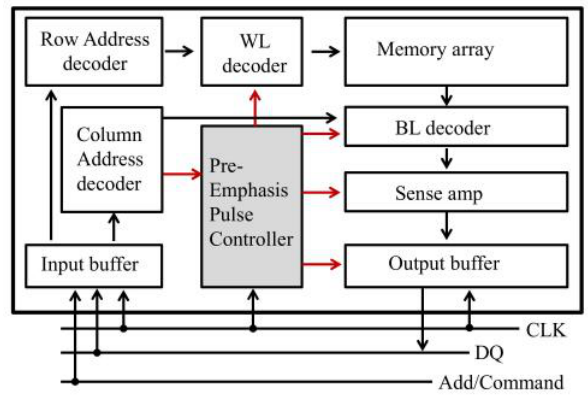
Figure 20. Block diagram of a proposed NVRAM.